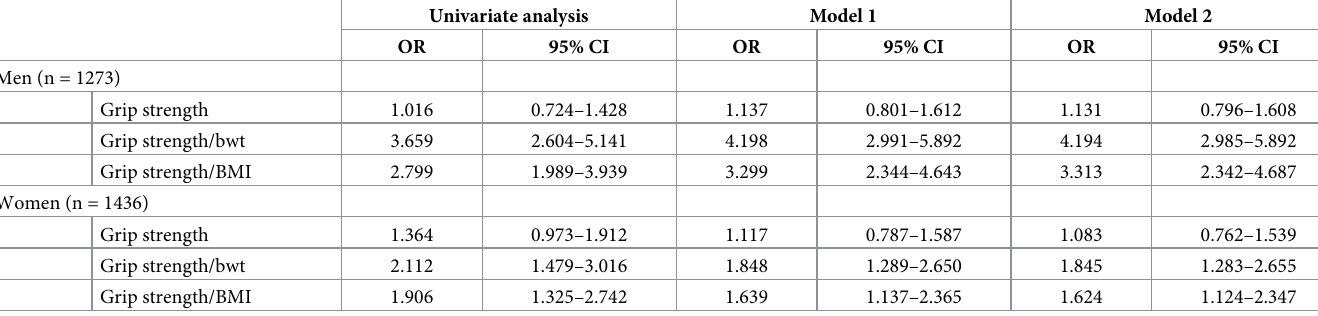
Table 2. Odds ratios of poor grip strength and poor normalized grip strength for metabolic syndrome.